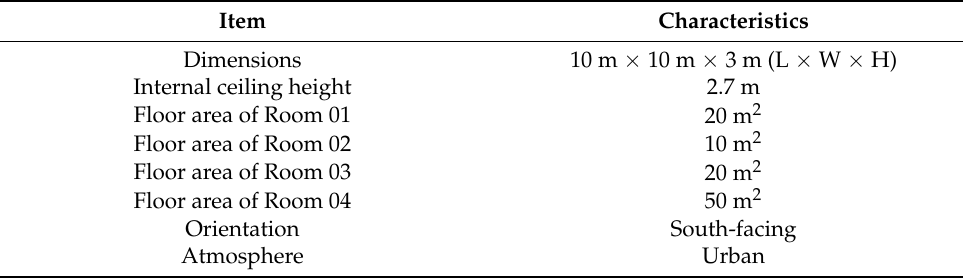
Table 2. Construction materials and thermal properties of the proposed